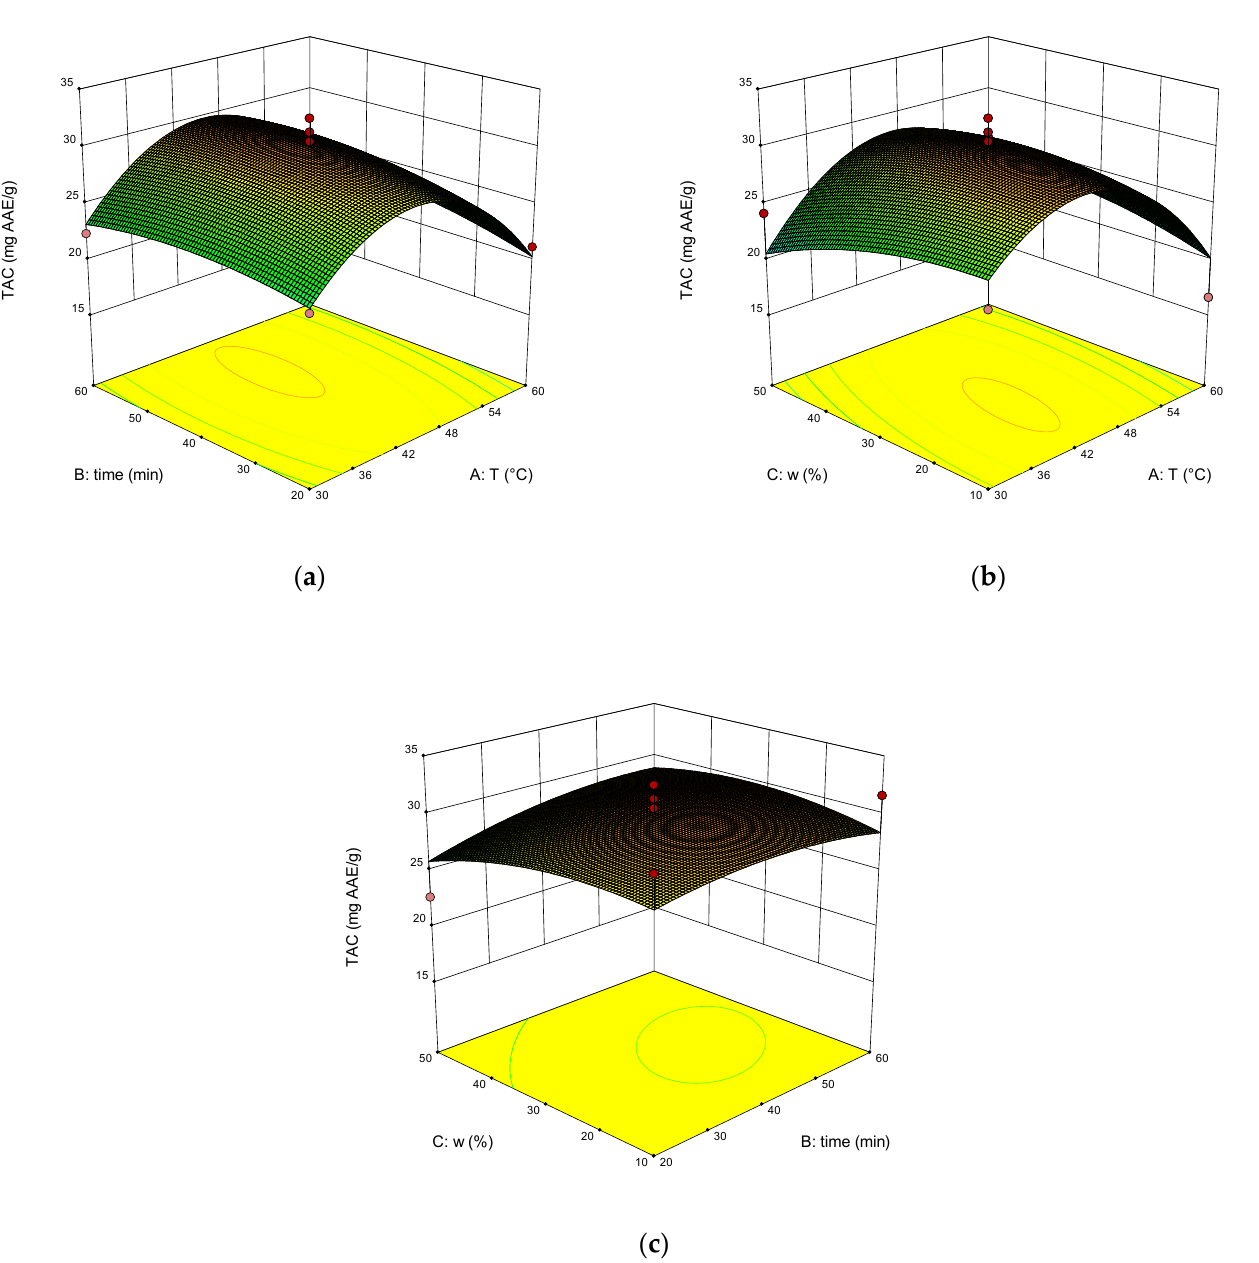
Figure 5. Response surface ( a – c ) shows the extraction temperature (A), extraction time (B) and water content (C) effect on the extraction yield of TAC.